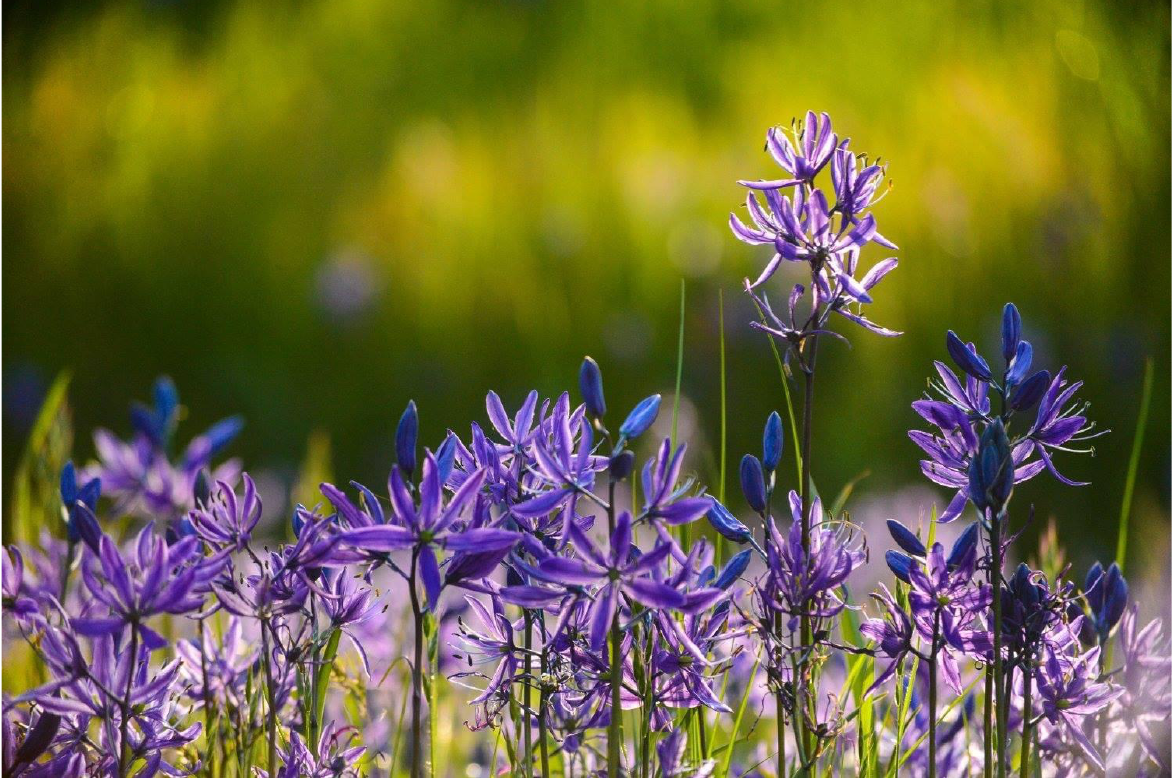
Figure 8: Camas is a significant food source for the Sinixt, Syilx, and Ktunaxa peoples. The location of large camas fields is in sight of anyone standing on the Castlegar Campus of Selkirk College. These fields were utilized by Sinixt people before colonization. Courtesy: Mike